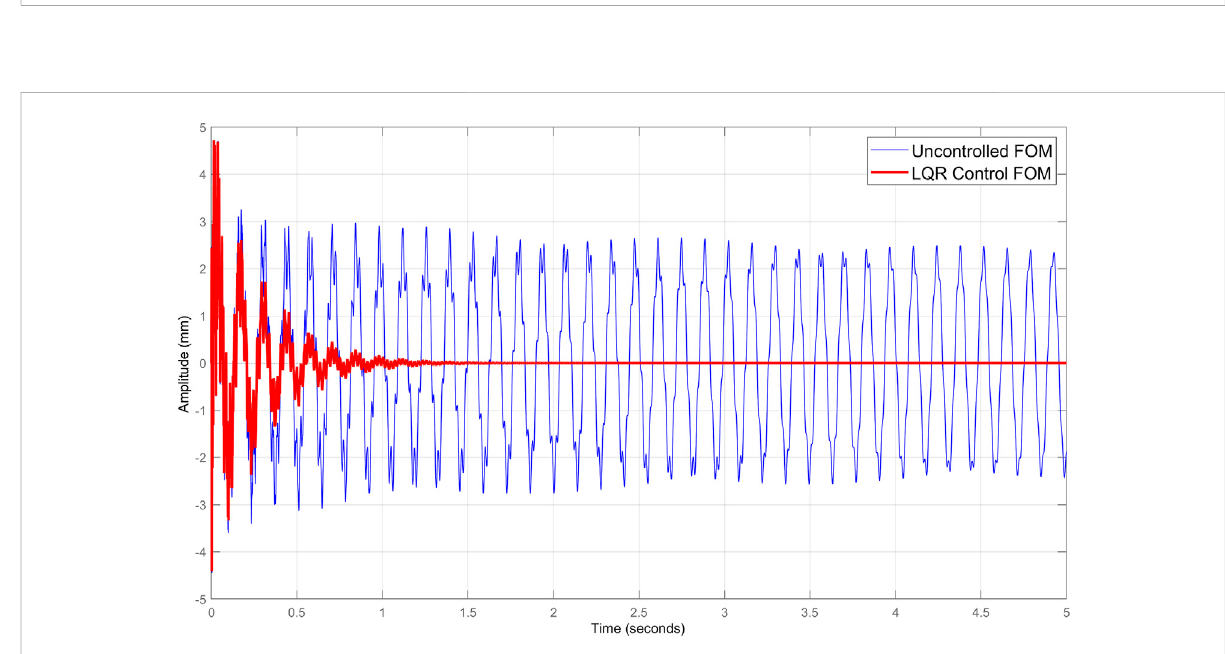
Impulse response in the full model case using LQR control and considering 112 dofs of 10 distributed